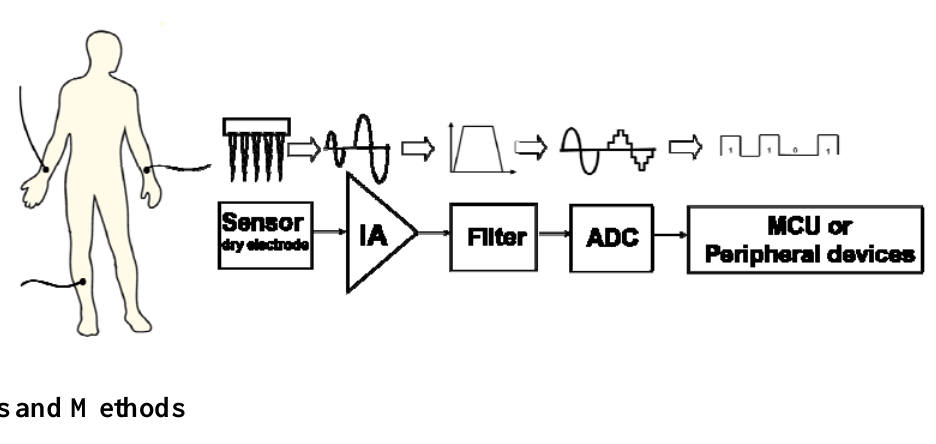
Figure 1. Block diagram of the bio-potential acquisition